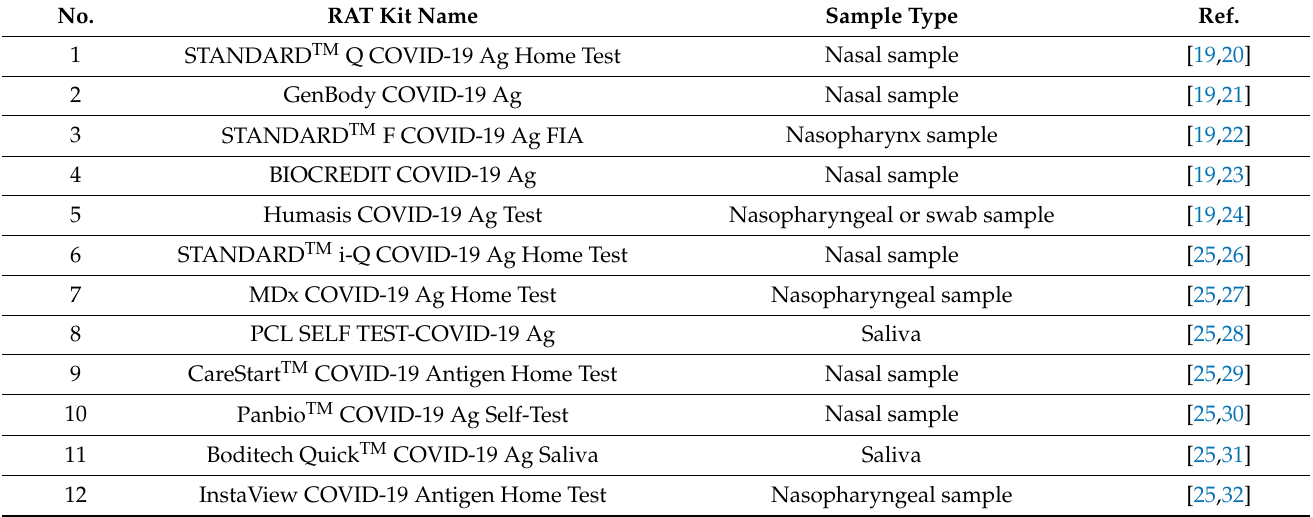
Table 1. Commercially available SARS-CoV-2 rapid antigen tests (RATs) in